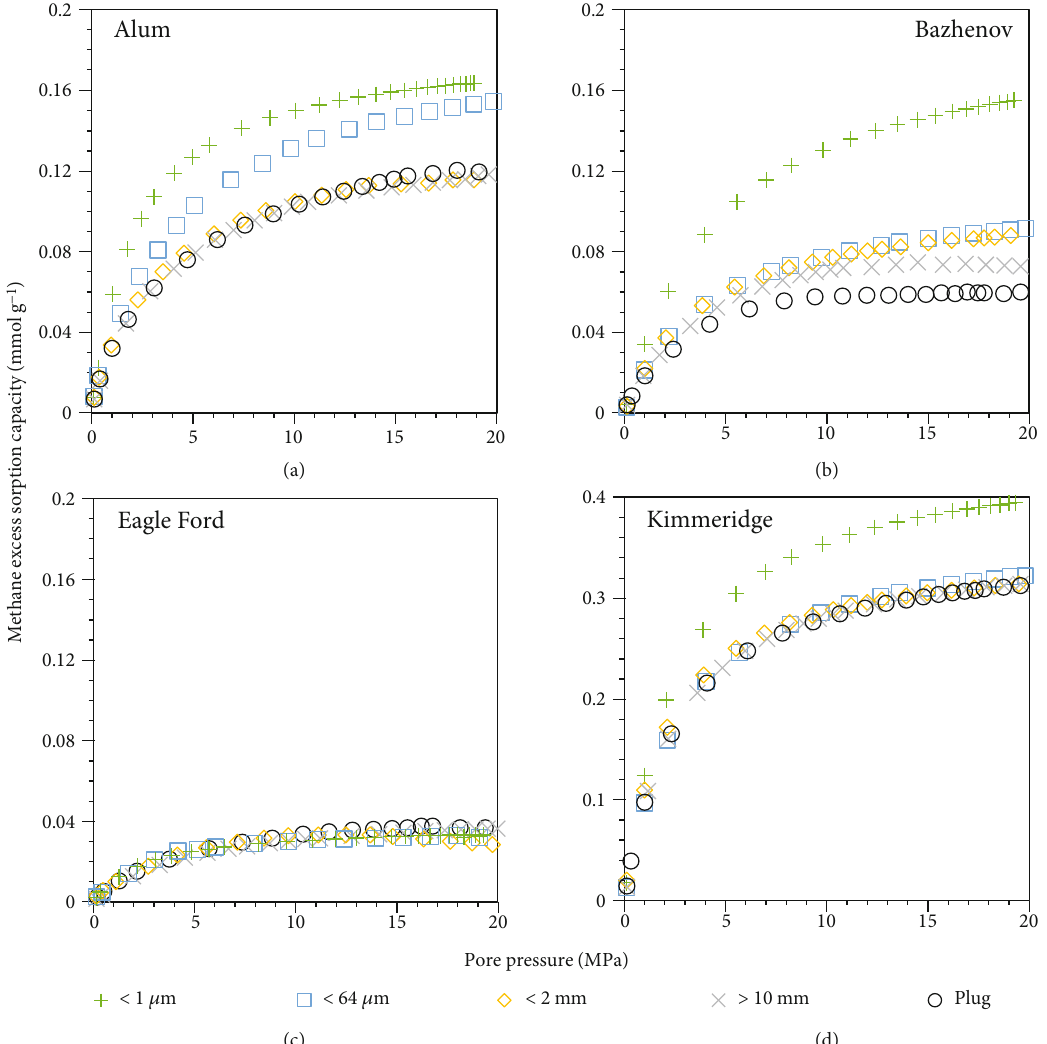
Figure 4: Methane sorption capacity as a function of particle size for shales from (a) Alum, (b) Bazhenov, (c) Eagle Ford, and (d) Kimmeridge